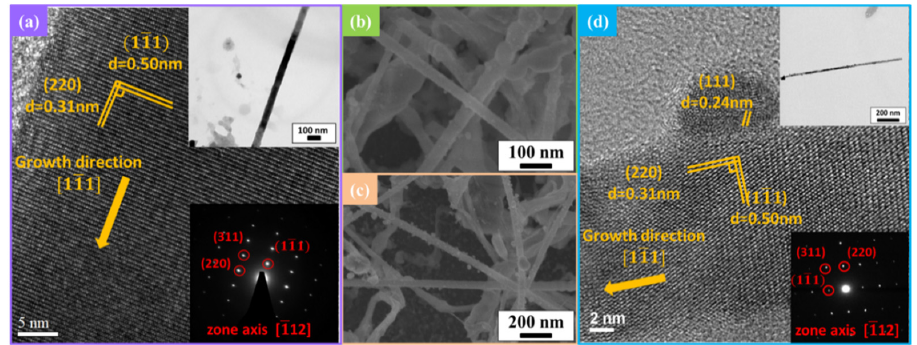
Figure 2. Morphology and structure analysis of ZTO NWs and Ag-ZTO NWs. ( a ) HRTEM image of ZTO NWs. ( b ) SEM image of 1 at% Ag-ZTO NWs. ( c ) SEM image of 3 at% Ag-ZTO NWs. ( d ) HRTEM image of Ag-ZTO